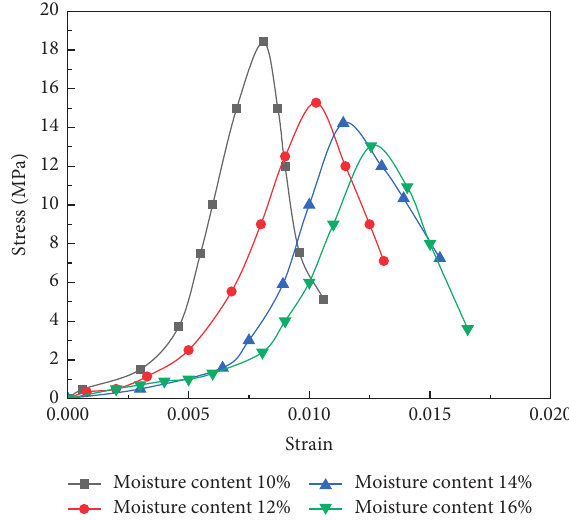
Figure 8: Stress-strain curves of molecular dynamics model.